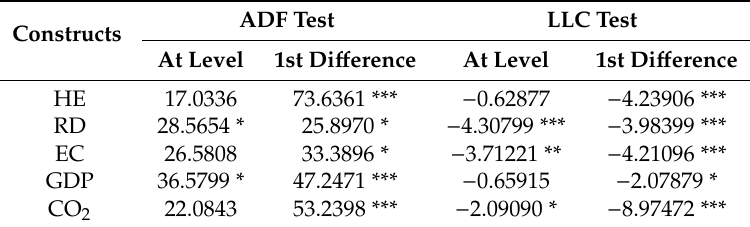
Figure 2. Joint Trends. Table 3. Unit Root Analysis.